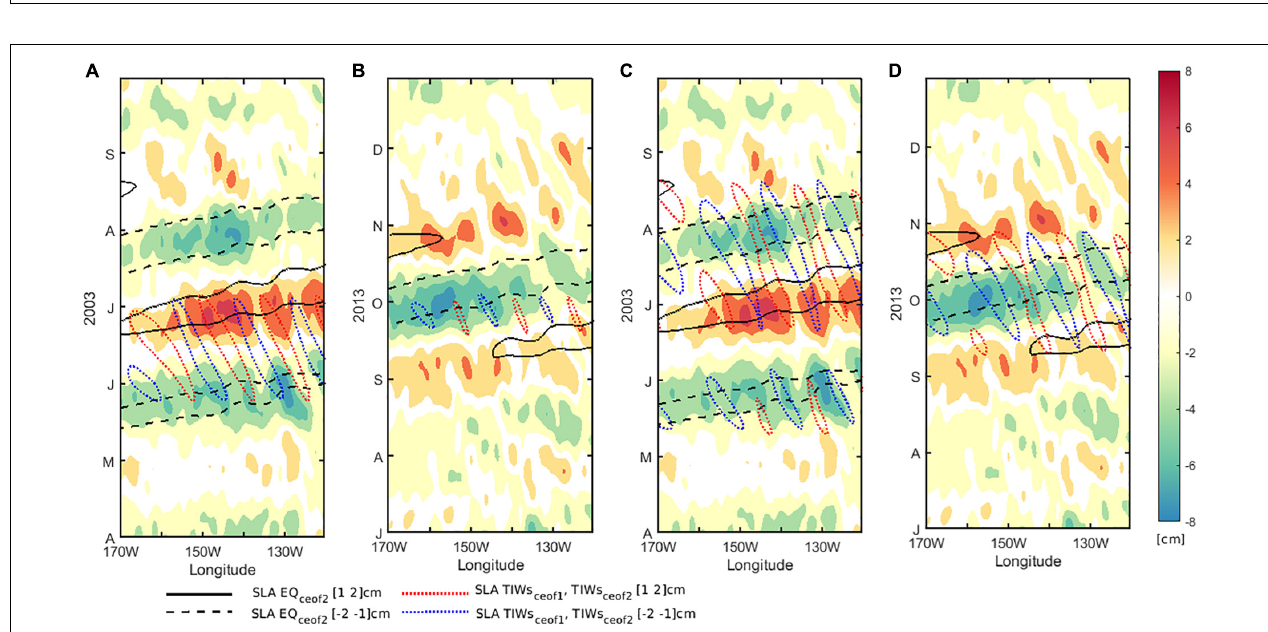
FIGURE 6 | IKWs and TIWs evolution during two periods ( A,C . April-September 2003 and B,D . July–December 2013): Hovmoller of total SLA (color) at the equator (2 ◦ S–2 ◦ N), SLA reconstructed from CEOF2 projected onto the Kelvin mode (upwelling/downwelling in dashed/continuous black contours, at the equator) and SLA reconstructed from CEOF 1 (A,B) and from CEOF2 (C,D) in the TIWs region (3 ◦ N–7 ◦ N) [dashed blue (red) lines for negative (positive) SLA].